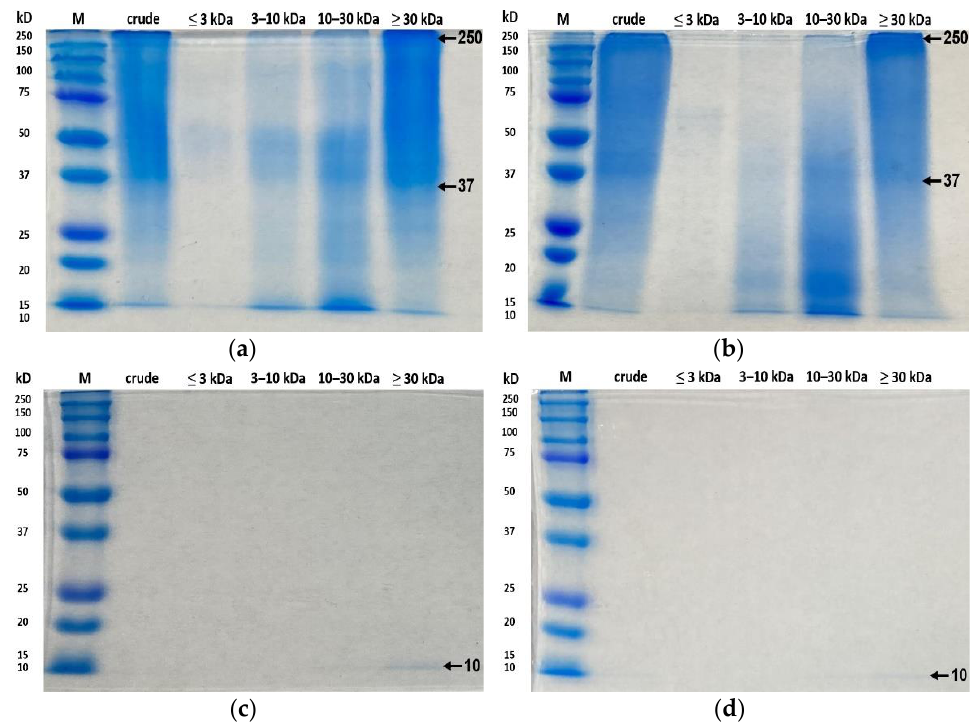
Figure 5. SDS-PAGE pattern of collagen hydrolysate fractions extracted from APS. ( a ) Control; ( b ) Ultrasound assisted extract; ( c ) Enzyme assisted extract ( d ) Combination of enzyme and ultrasound assisted extraction methods.